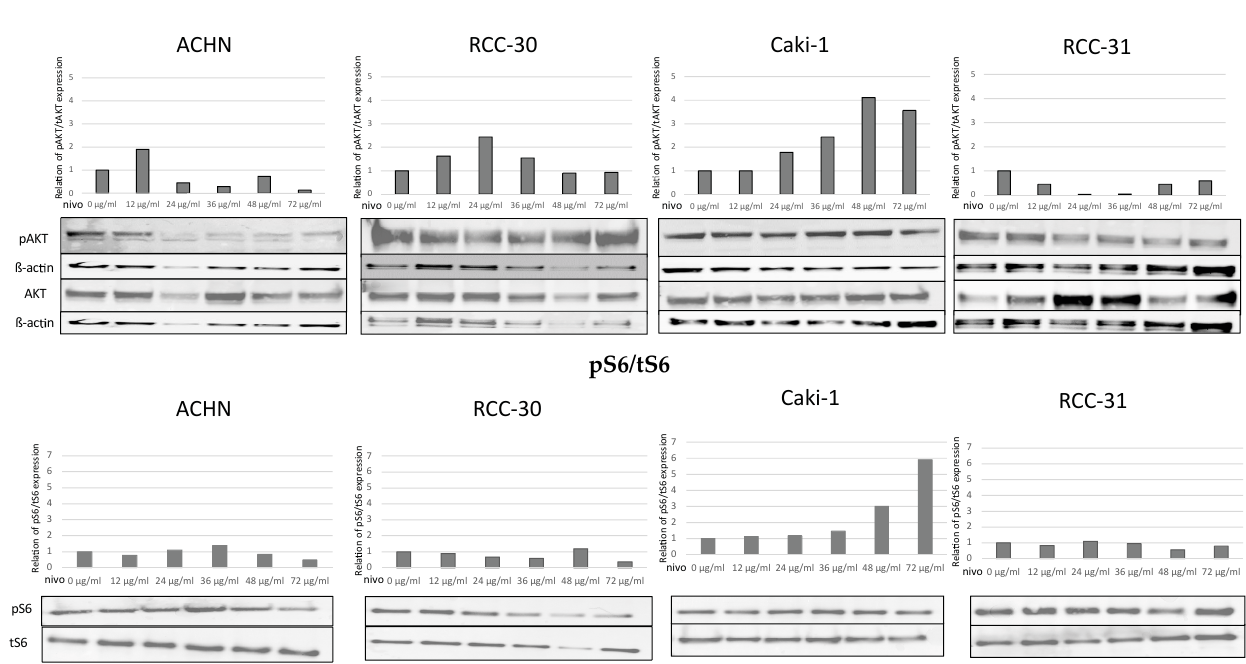
Figure 2. Status of AKT and S6 activation. The relationship between p/t expression of tAKT and pAKT as well as S6/pS6 in RCC cell lines was defined as the protein activation status.